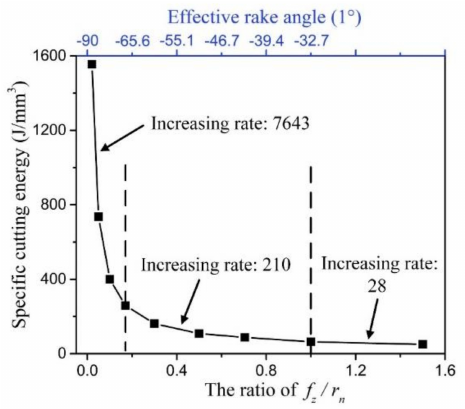
Figure 11. The specific cutting energy curve varies with the ratio of f z / r n .